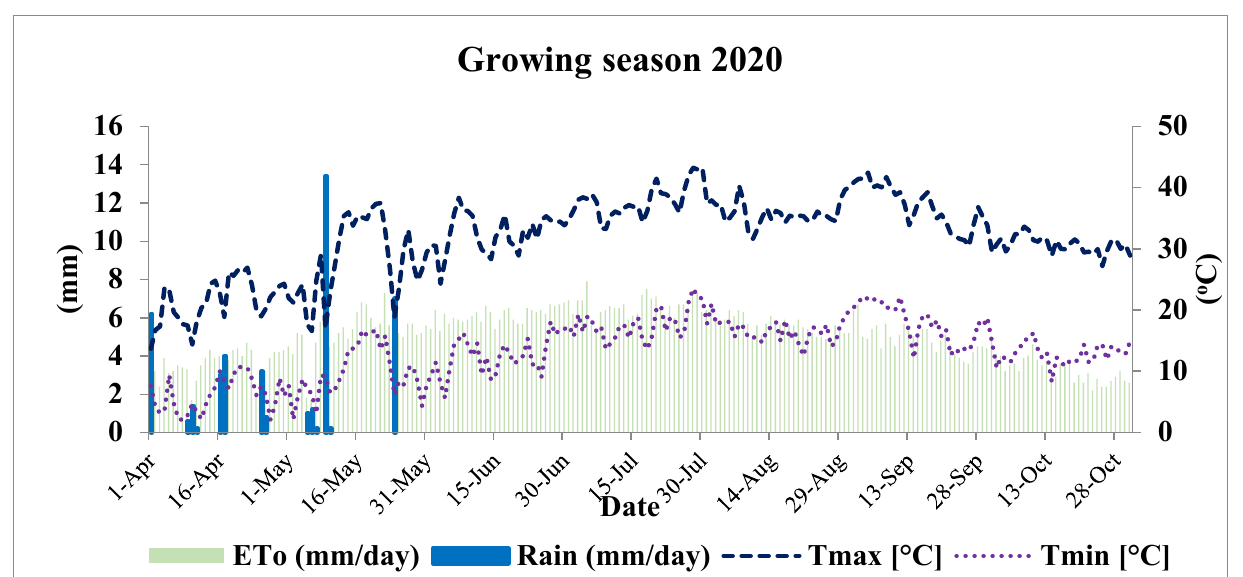
Figure 1. Rainfall (mm), maximum and minimum temperatures (°C), and reference evapotranspiration (ETo; mm) for the growing season of 2020.